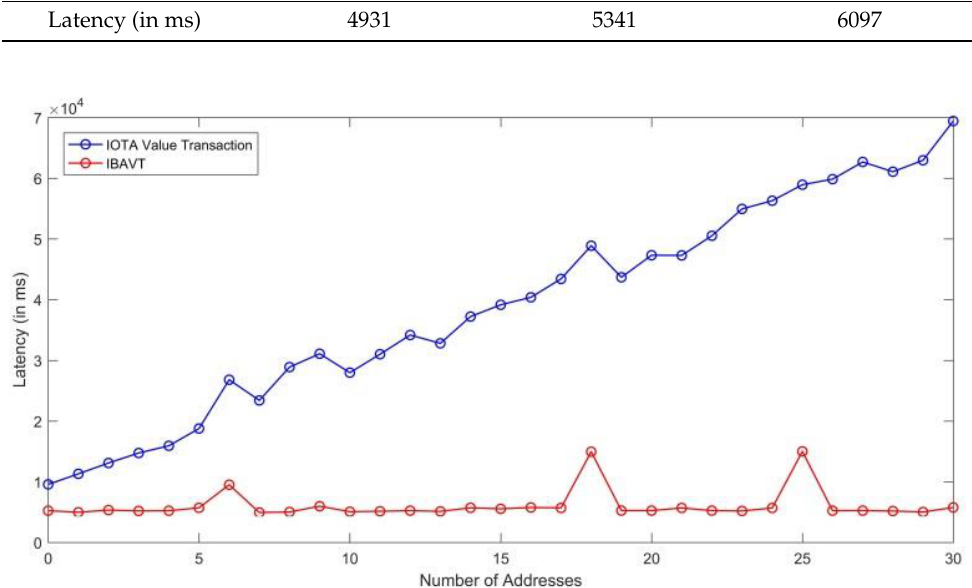
Table 4. Latency achieved in IBAVT.